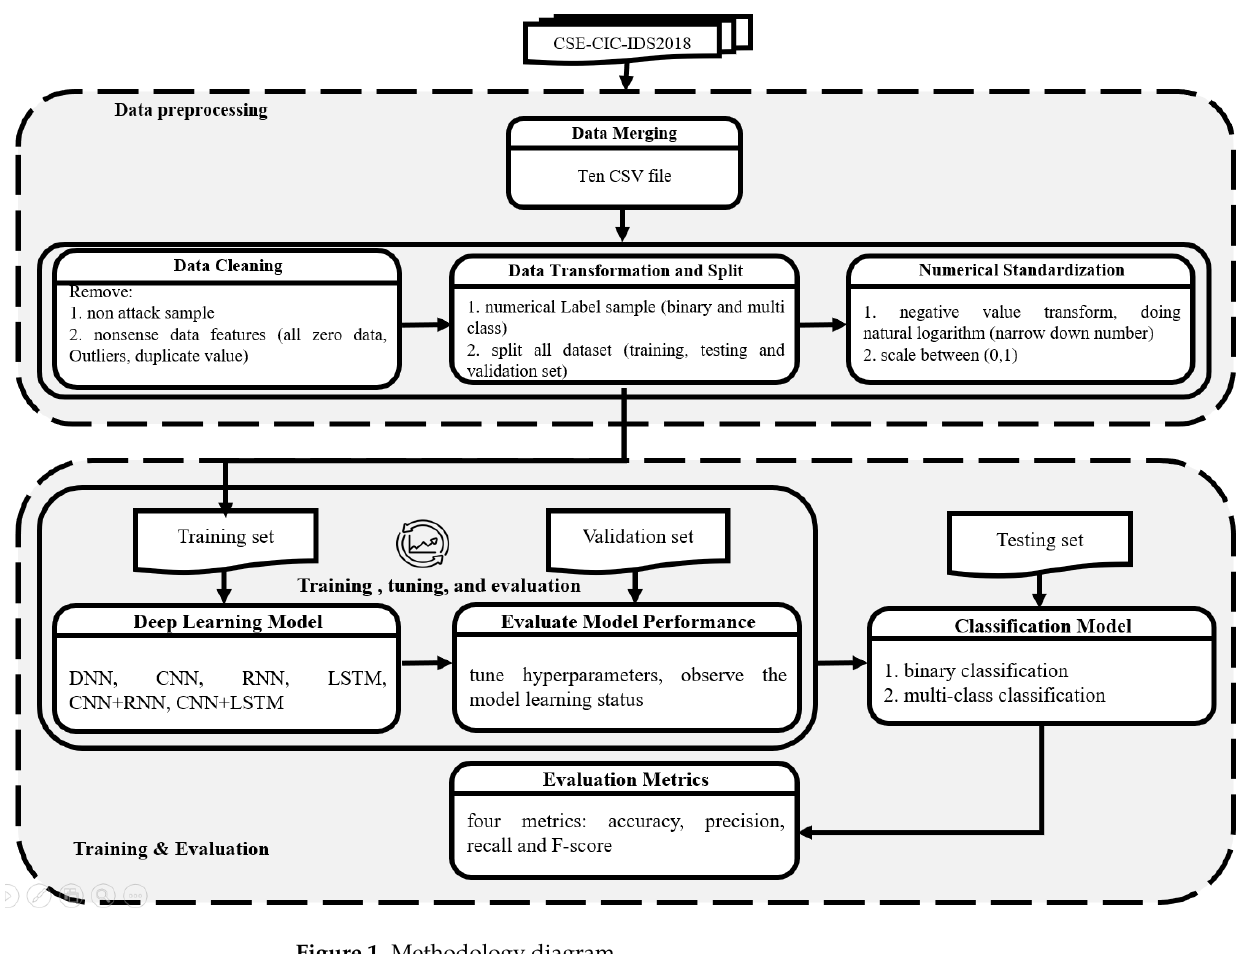
Figure 1. Methodology diagram. Table 2. List of attack